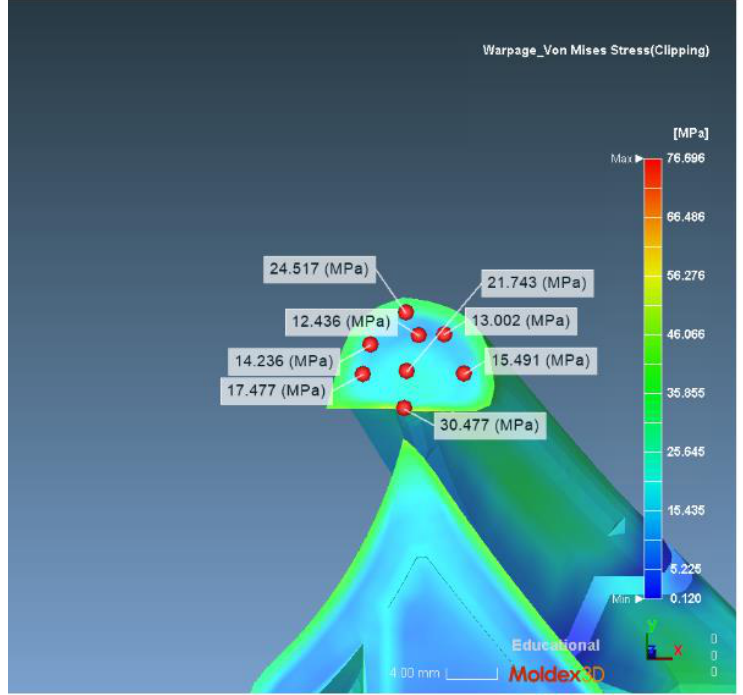
Figure 5. Resolution of the 0.46 radius theoretical stress concentration factor. (2) Calculation of the theoretical stress concentration factor with a notch radius of 0.51 mm. Similarly, we select eight points on the model section with a notch radius of 0.51 mm, as shown in Figure 6. The resulting stress levels are: 24.517 MPa, 14.236 MPa, 15.491 MPa, 21.743 MPa, 12.436 MPa, 17.477 MPa, 13.002 MPa, and 30.477 MPa. We take its average value: 18.297 MPa.